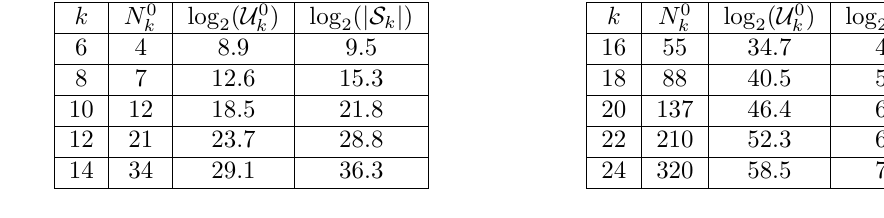
Table 8: Comparison between U 0